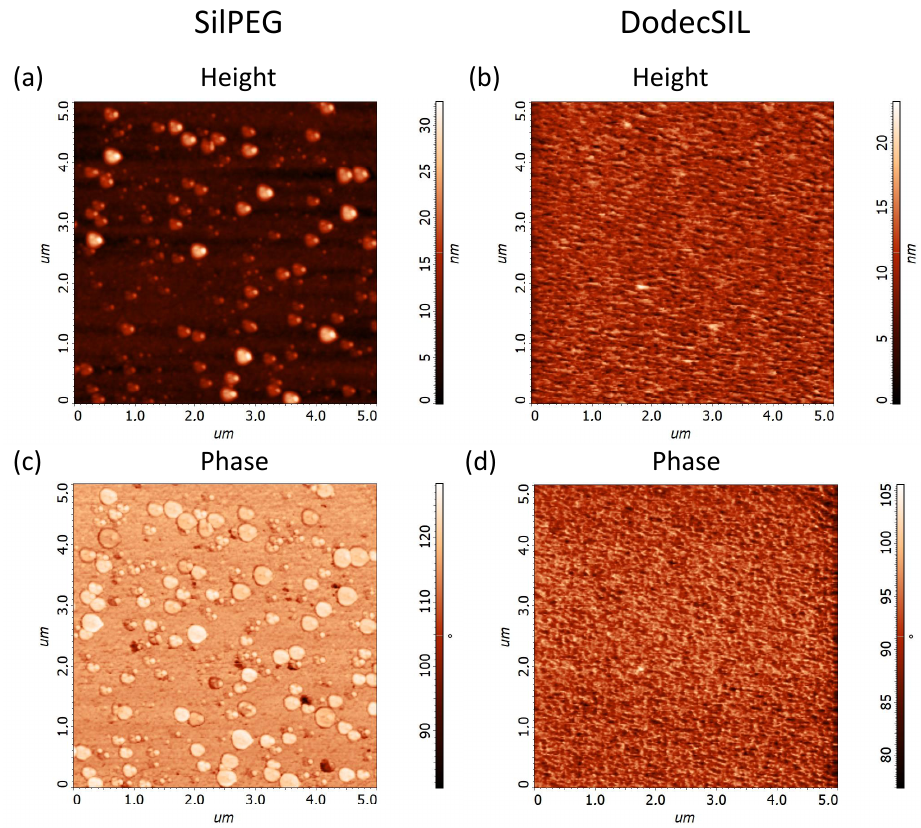
Figure 2. AFM images of polymer films from 5 × 5 µ m area: ( a ) SilPEG height (RMS = 3.7 nm) ( b ) DodecSIL (RMS = 2.3 nm) height; ( c ) SilPEG phase; ( d ) DodecSIL